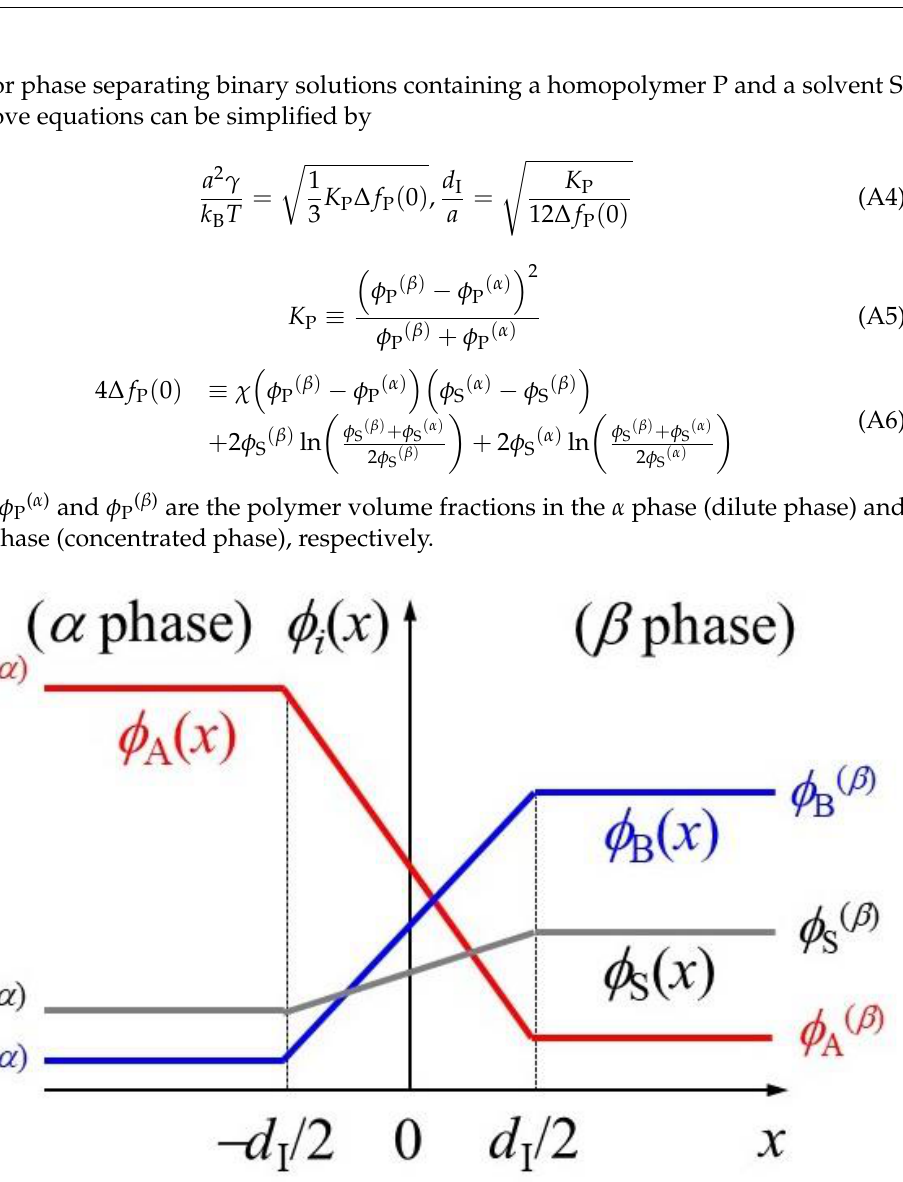
Figure A1. Concentration distribution of homopolymers A and B and the solvent near the interfacial region in the phase-separating ternary solution.